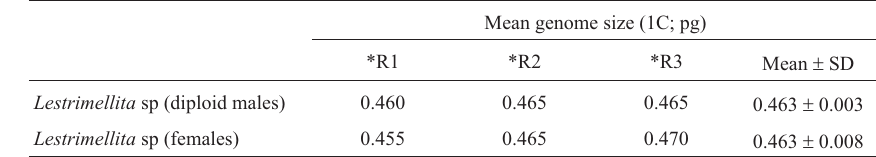
Table 1 - Estimation of genome size of cerebral ganglia of Lestrimelitta sp.